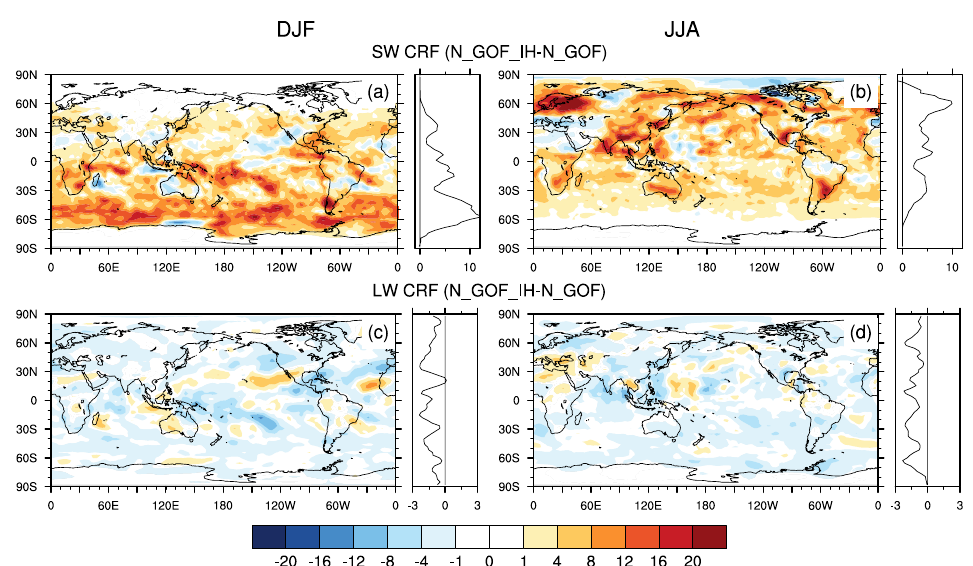
Fig. 13. Differences in (a, b) SW CRF and (c, d) LW CRF between N_GOF_IH and N_GOF, for DJF (left) and JJA